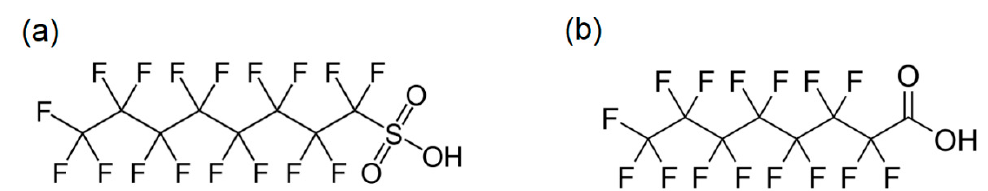
Figure 1. Structure of ( a ) Perfluorooctane sulfonate (PFOS) and ( b ) Perfluorooctanoic acid (PFOA).